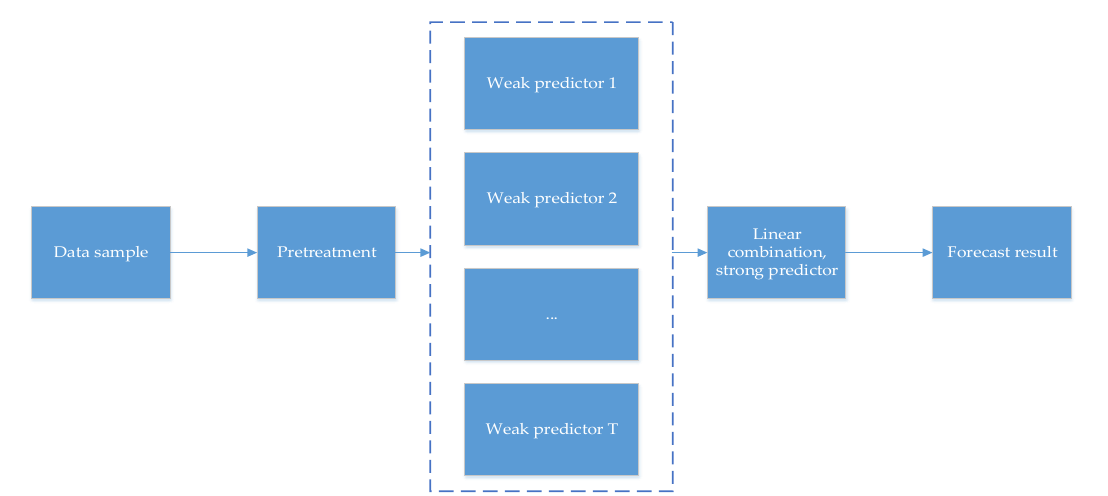
Figure2. AdaBoost Algorithm Diagram. Figure 2. AdaBoost Algorithm Diagram.